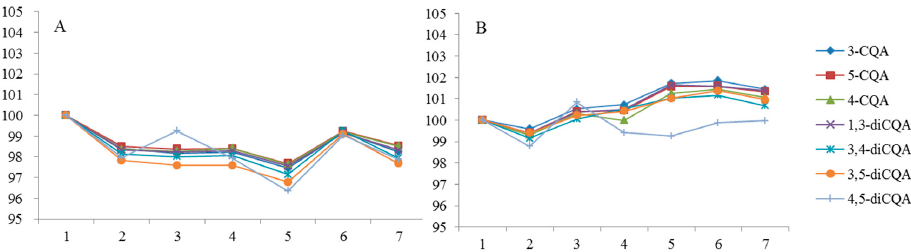
Figure 5. Stability of CQAs of different solvent in brown bottle at refrigerator. ( A ) 50% ( v / v ) aqueous methanol; ( B ) Methanol.